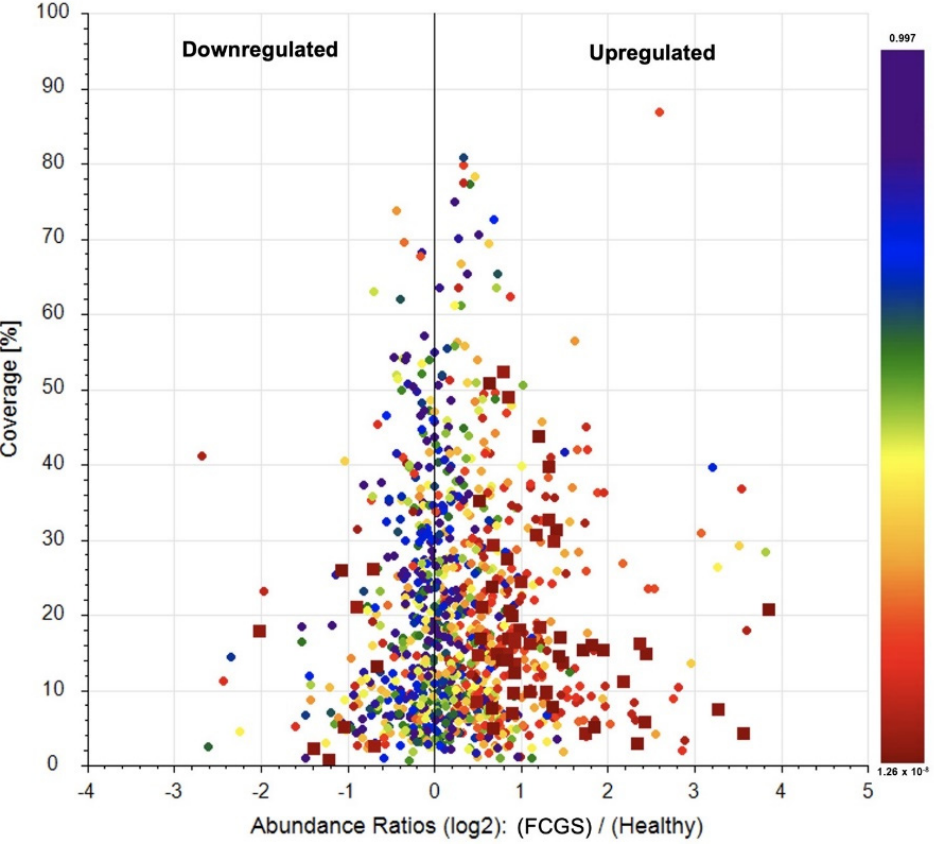
Figure 4. Proteins up- and downregulated in the FCGS cats. Scatter plots showing the percentages of protein sequence coverage vs. their Log2 fold change abundance values in the secretome from FCGS cats versus healthy donors. Proteins were ranked according to their p -values from red to blue color. A protein was considered down- or upregulated (red squares) when its fold-change value was <0.5 or >2, respectively, with a p -value < 0.05.